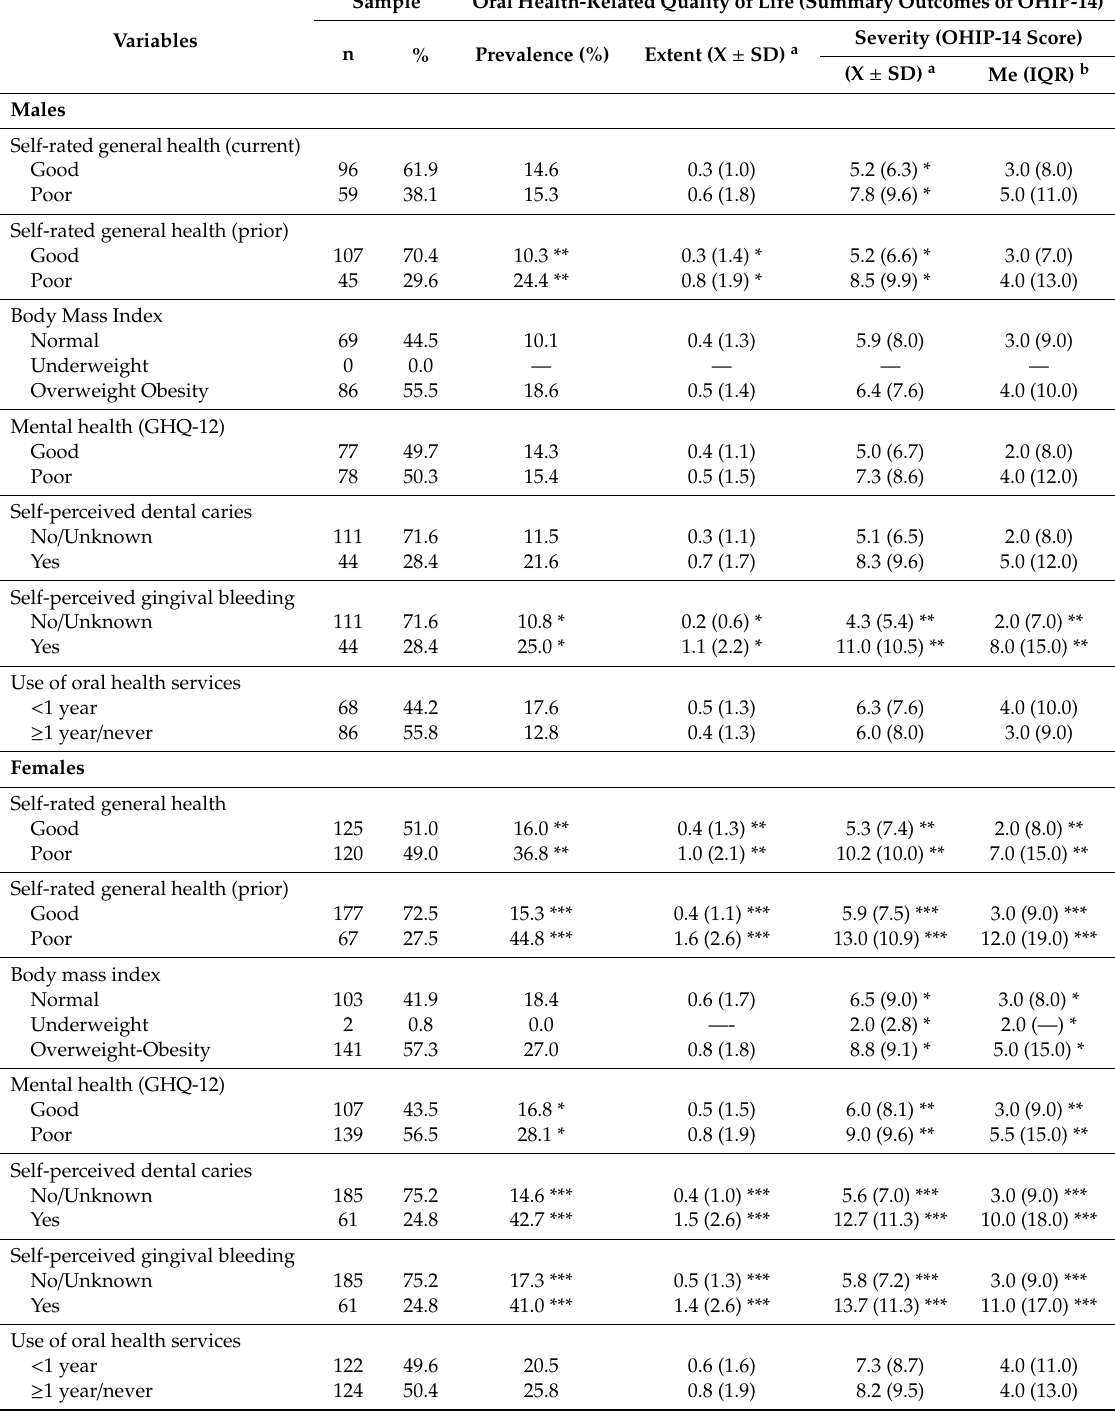
Table 3. Summary outcomes of the OHIP-14 as a proxy of oral health-related quality of life by health variables in the PELFI cohort, Spain (n =